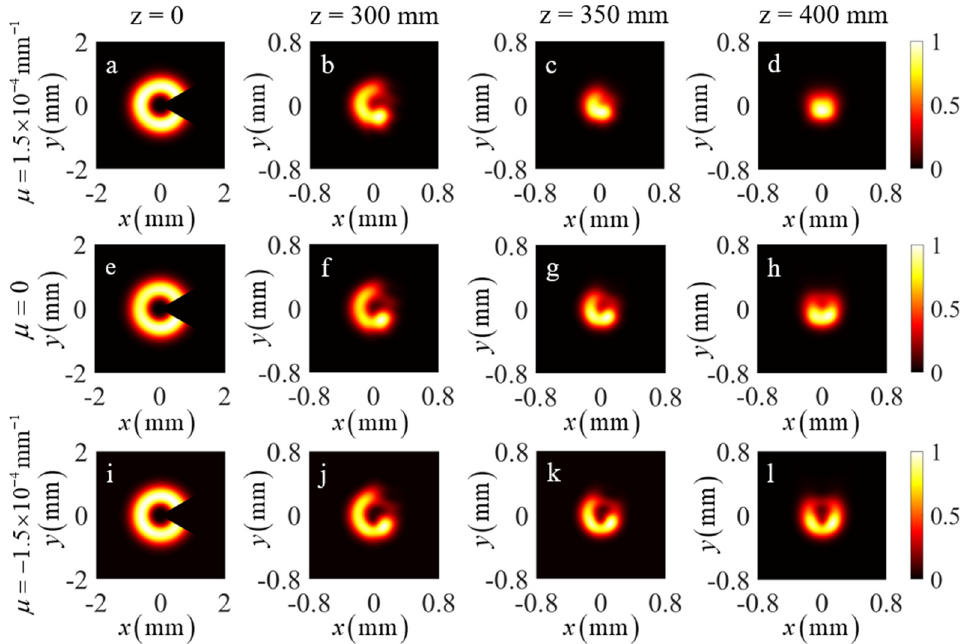
Figure 5. The simulation results for the spectral density at different propagation distances of a TLGSM beam with ( a – d ) the twist factor µ = 1.5 × 10 − 4 mm − 1 , ( e – h ) µ = 0, and ( i – l ) µ = − 1.5 × 10 − 4 mm − 1 . The TLGSM beam is obstructed by a sector-shaped opaque obstacle with center angle α = π/3 .